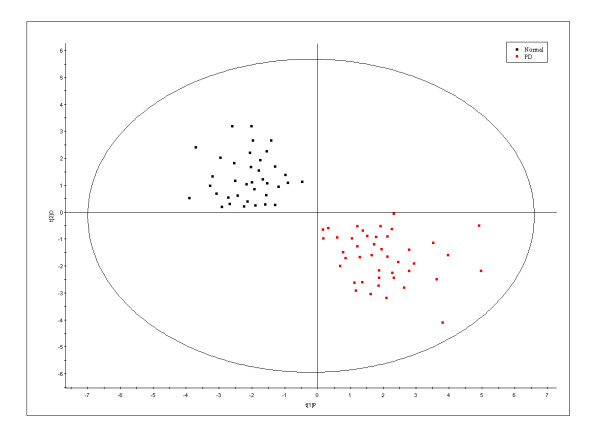
Partial least square discriminant analysis. PLS-DA scores plot showing a significant separation between control subjects (n = 37) and unmedicated PD patients (n = 43) using complete digital maps. The observations coded according to class membership: black square = controls; red square = PD patients.